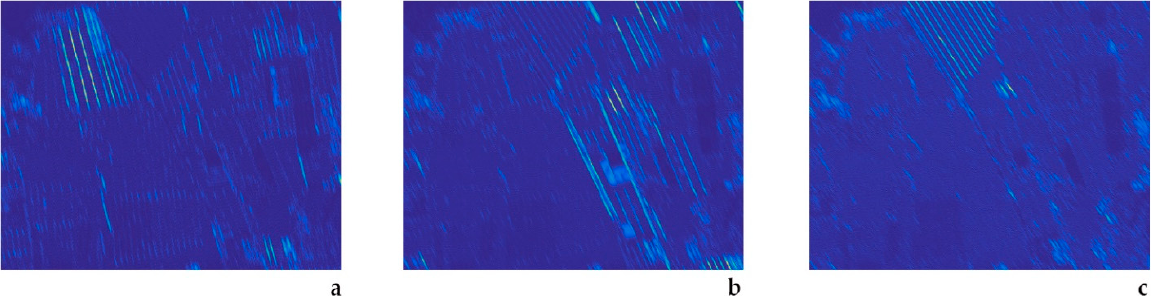
Figure 5. Accumulation of the responses of the Gabor filter bank across channels and scales. Each image corresponds to responses at the same locations and different orientations of the filter: ( a ) 12 ◦ W from N; ( b ) 22 ◦ W from N; ( c ) 32 ◦ W from N.